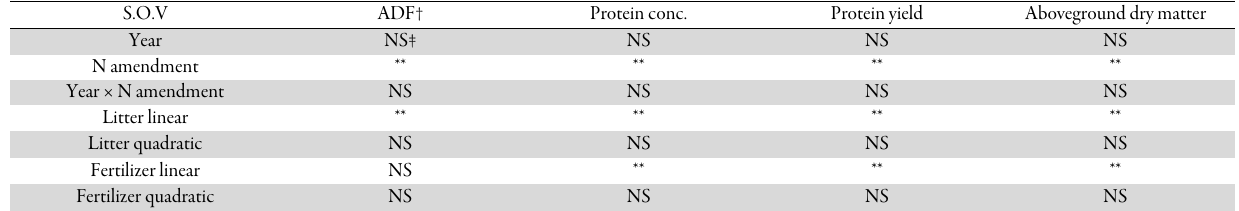
Fig. 6. The effects of N source and rate on NDF concentration of silage corn. Means with the different letters show significant difference (LSD, P ≤ 0.05). See Fig. 2 for abbreviations Table 3. The effects of N source and rate on ADF, protein concentration, protein yield and aboveground dry matter of silage corn